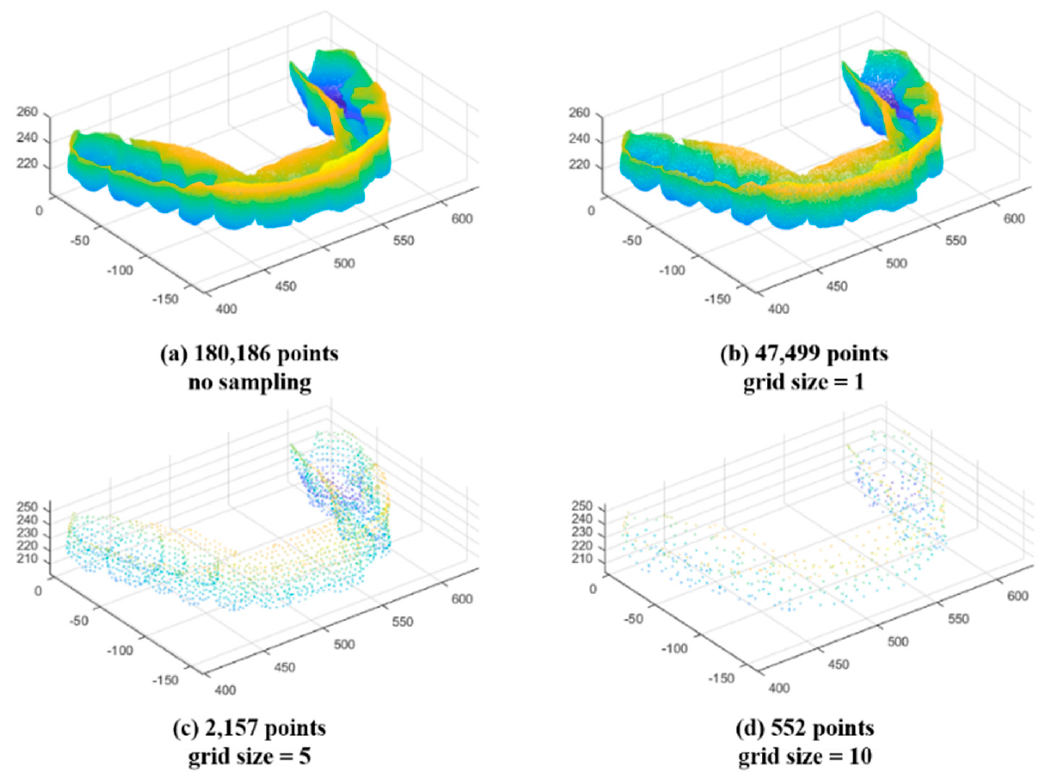
Figure 8. Uniform sampling results. ( a ) No sampling, ( b ) uniform sampling (grid size = 1 voxel) ( c ) uniform sampling (grid size = 5 voxels), ( d ) uniform sampling (grid size = 10 voxels).